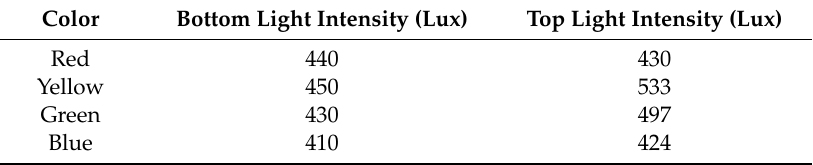
Table A2. Wavelength (spectrum), reflectance, and irradiance (emission intensity) of all color plates.